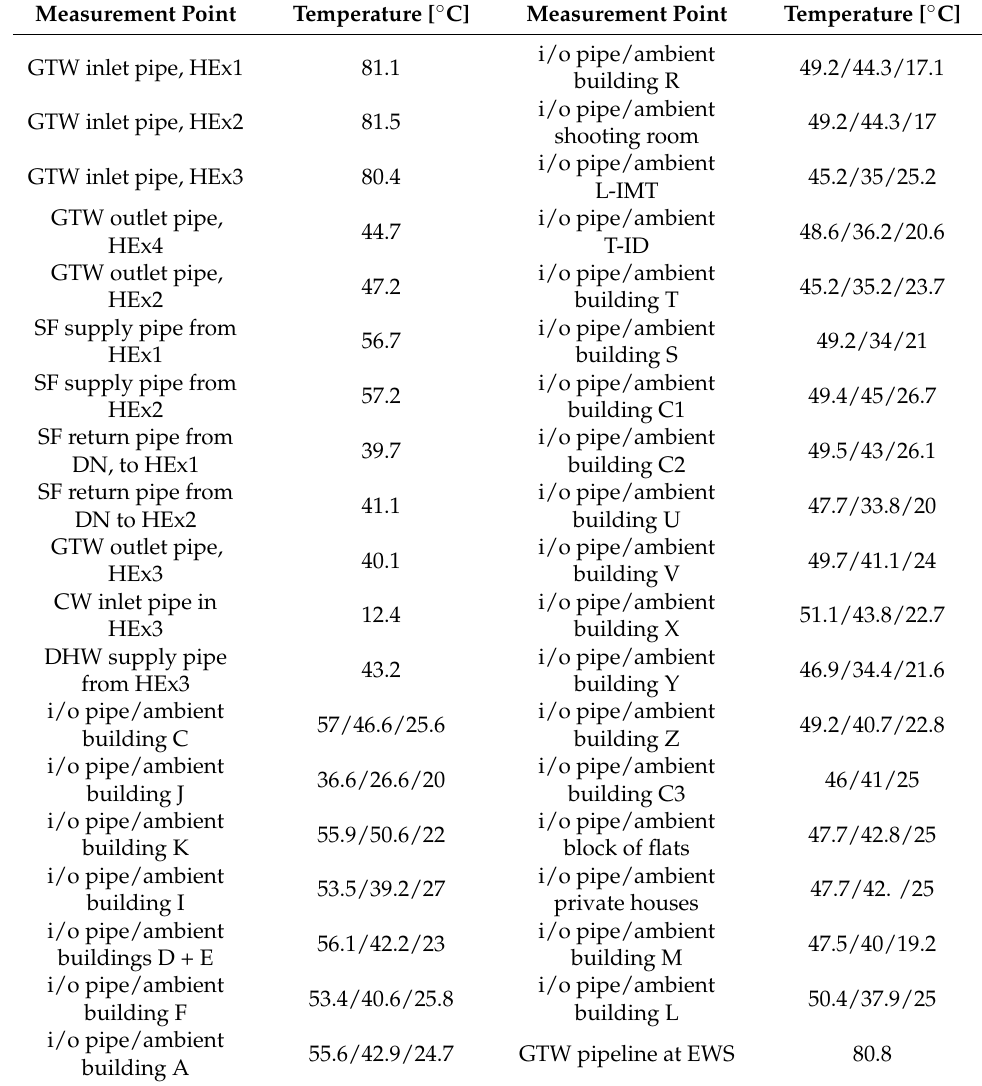
Table A2. HSGWPE temperature measurements using thermal